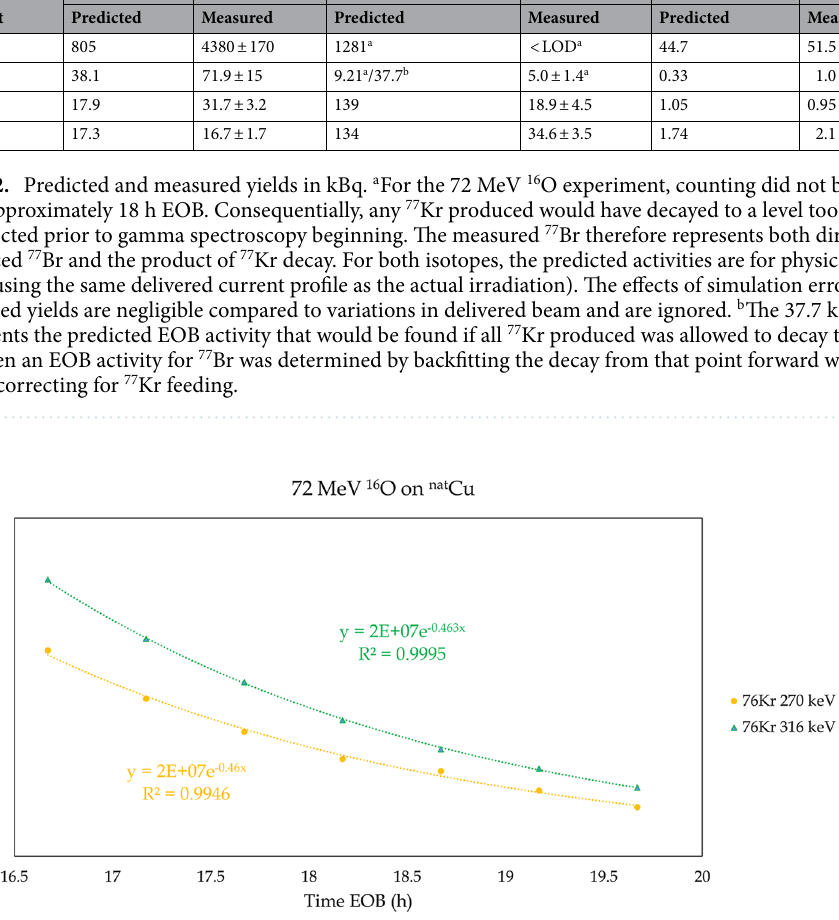
Figure 9. Activity vs time for two gamma signatures of 76 Kr for the first seven spectra taken for this system. The decays are fit with simple exponentials, and the half-life of the decays is found to be 1.5 ± 0.01 h.